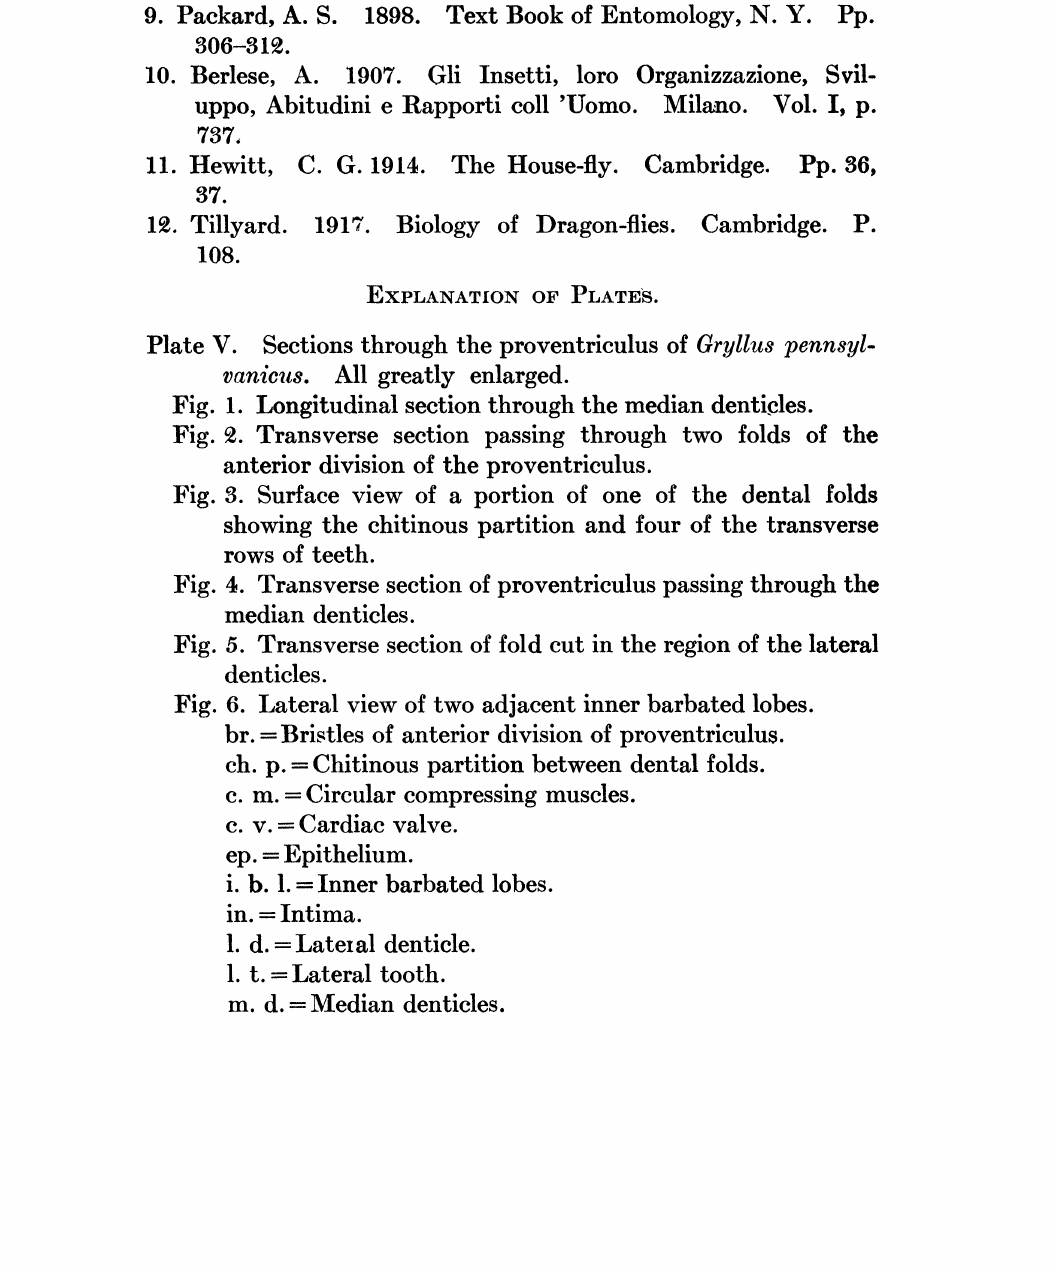
Fig. 1. Longitudinal section through the median denti.cles. Fig. 2. Transverse section passing through two folds of the anterior division of the proventriculus. Fig. 3. Surface view of a portion of one of the dental folds showing the chitinous partition and four of the transverse rows of teeth. Fig. 4. Transverse section of proventriculus passing through the median denticles. Fig. 5. Transverse section of fold cut in the region of the lateral denticles. Fig. 6. Lateral view of two adjacent inner barbated lobes.